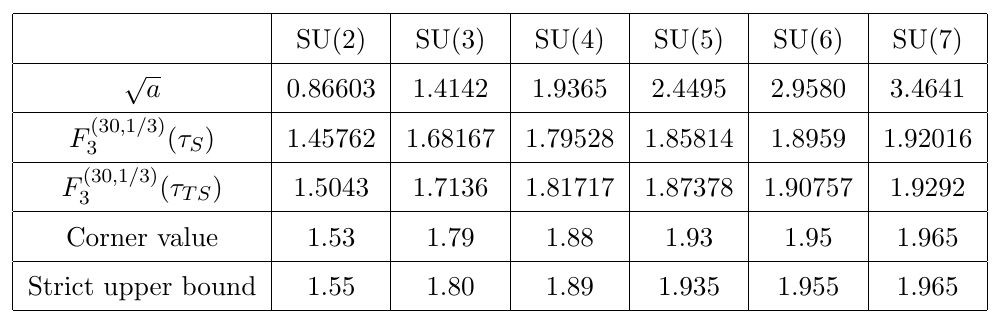
Table 4 . The interpolating function for spin-4 at the duality invariant points and data from the N = 4 superconformal